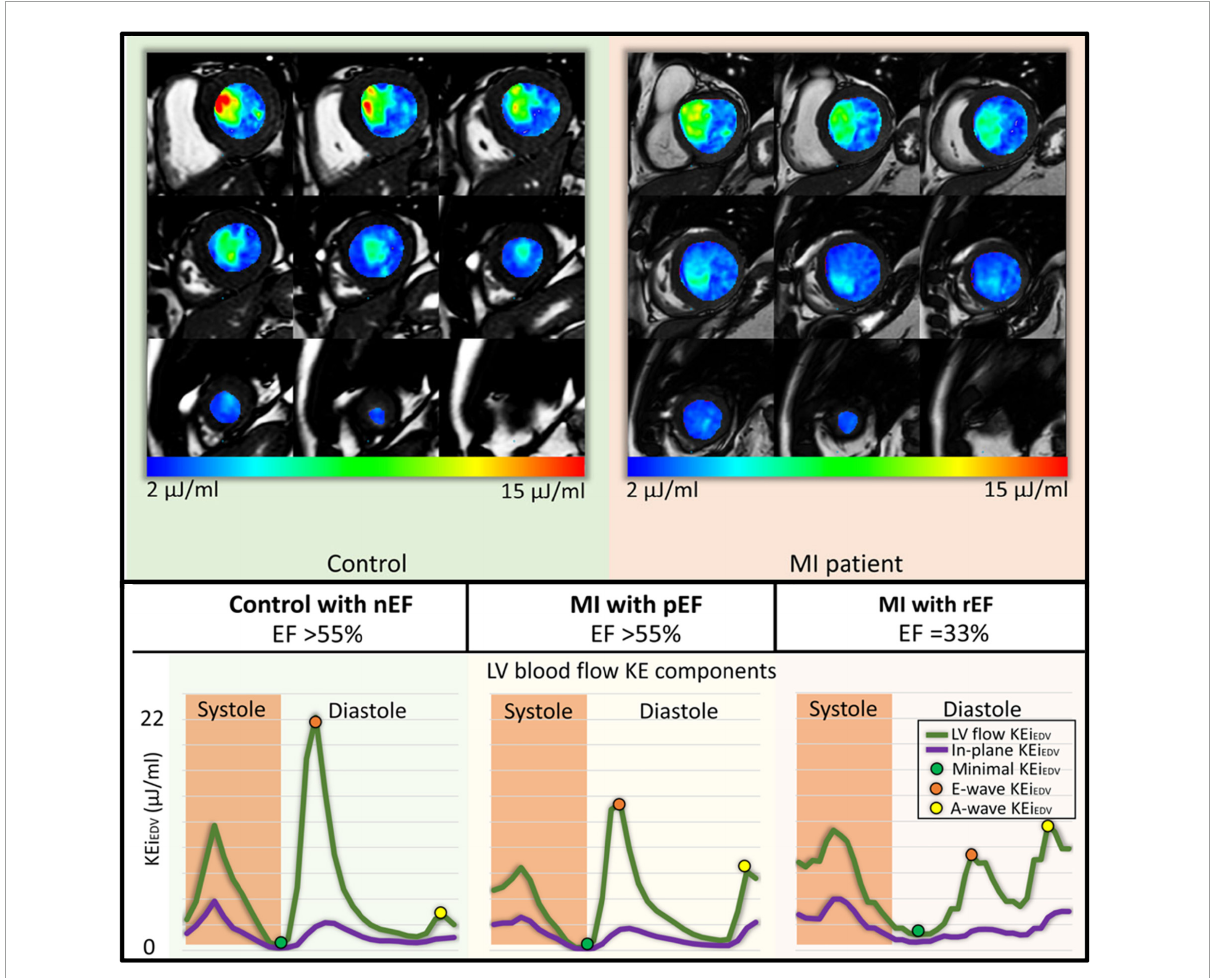
FIGURE3 Left ventricular kinetic energy maps in a control and an MI patient (Top) . Kinetic energy curves in a control and two MI patients with preserved left ventricular ejection fraction (pEF) and reduced left ventricular ejection fraction (rEF) showing reduced peak E-wave KE (Bottom)